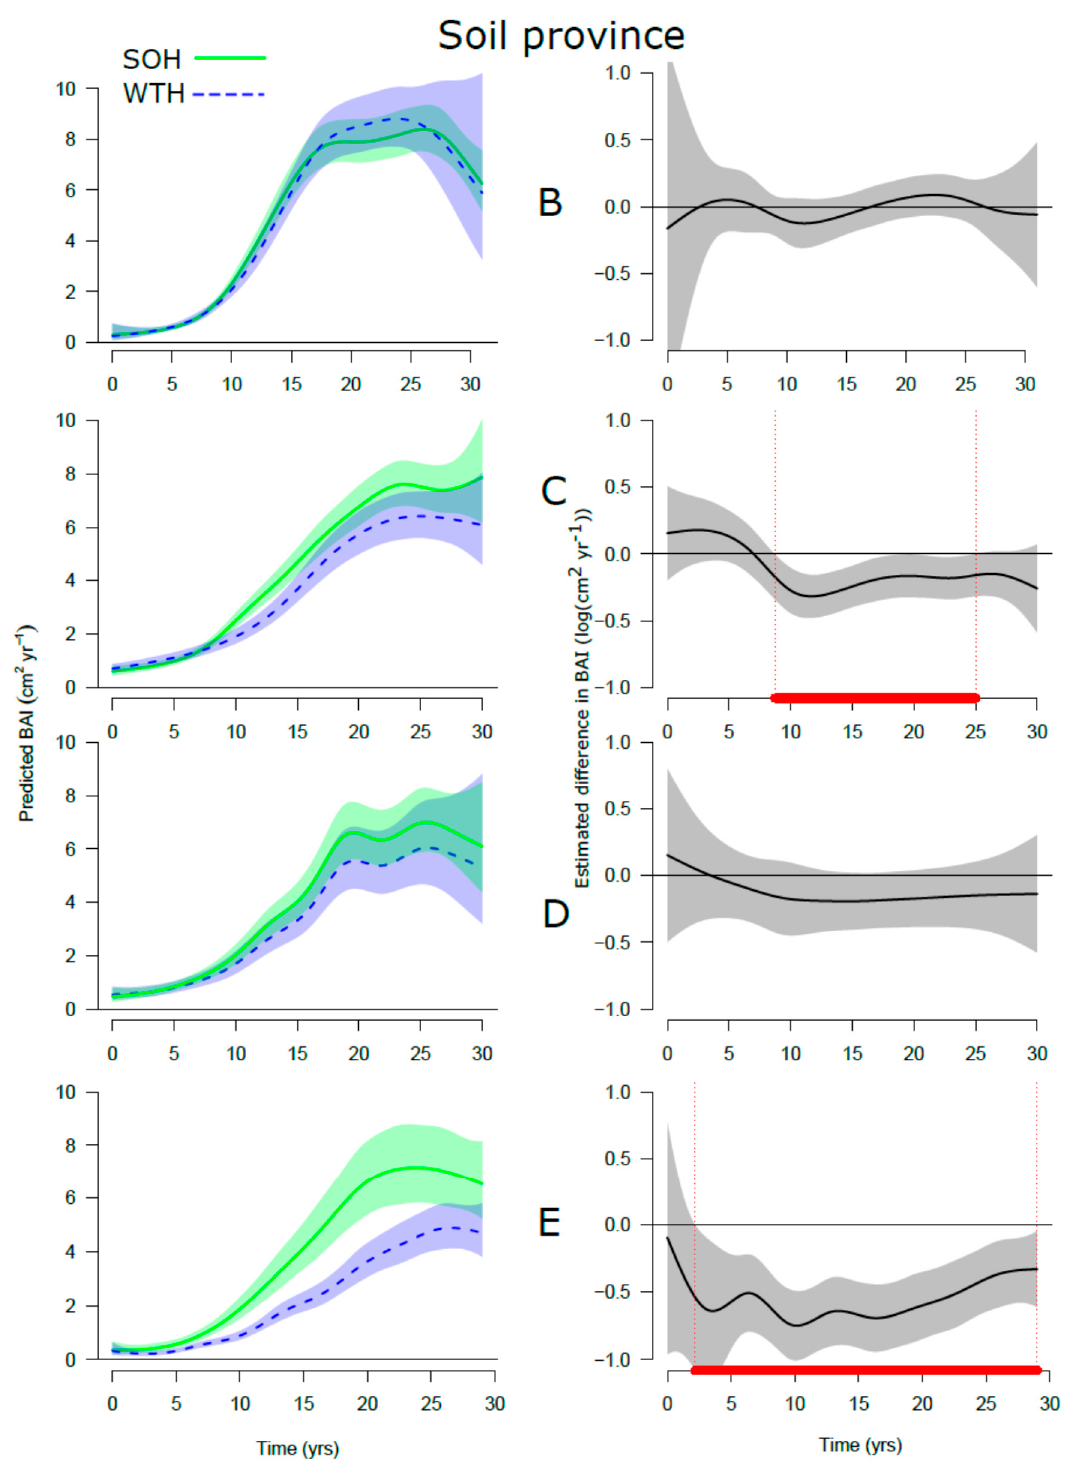
Figure 6. Left panels: Predicted basal area increment (BAI) of regenerating trees (all species confounded) over time after harvesting treatment (stem-only harvesting (SOH) and whole-tree harvesting (WTH)) in four soil provinces of Quebec: B = Appalachians; C = Laurentians; D = Abitibi Lowlands; E = Mistassini Highlands. Data presented are model averages (lines) and simultaneous confidence intervals (bands) (± 95 % CI). Right panels: Estimated difference in BAI (log values, simultaneous ± 95% CI) between WTH and SOH (WTH minus SOH) smoothed curves. Periods during which treatments differ significantly are highlighted with a red line on the X axis.